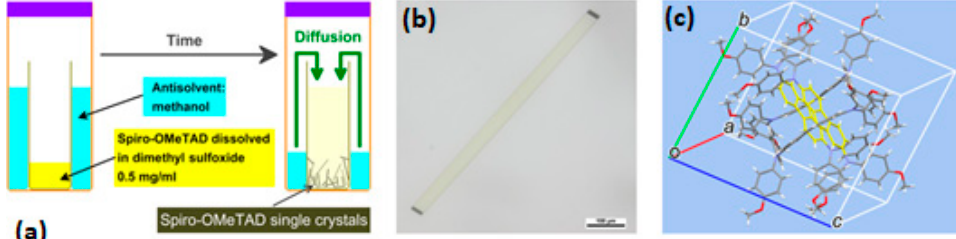
Figure 6. Crystal growth, shape, and crystallography. ( a ) Schematic diagram of the crystallization process. ( b ) Confocal optical microscopy image of a spiro-OMeTAD single crystal. ( c ) Unit cell of the single-crystal structure of spiro-OMeTAD (the fluorene fragments are highlighted in yellow). Reproduced with permission from ref. [75]. Copyright 2016, AAAS.